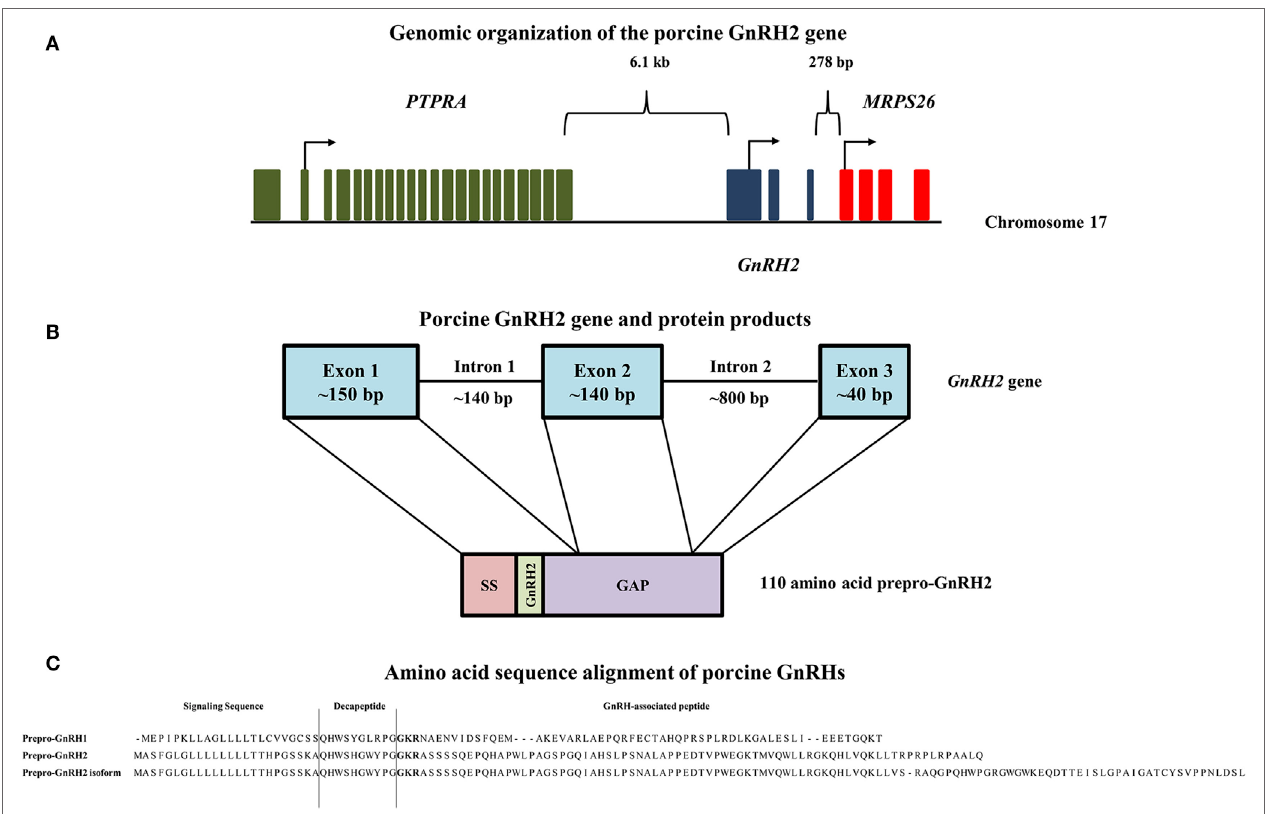
FiGURe 1 | Genomic organization of the porcine GnRH2 gene and its products. (A) The PTPRA gene (green) is located 6.1 kb upstream, whereas the MRPS26 gene (red) is positioned 278 bp downstream of the porcine GnRH2 gene (blue) on chromosome 17. Arrows indicate start codons for each gene. (B) The porcine GnRH2 gene contains three coding exons and two introns. Exon 1 (~150 bp) of the porcine GnRH2 gene encodes the signaling sequence (SS), mature GnRH2 decapeptide, and a portion of the GnRH-associated peptide (GAP). Exon 2 (~140 bp) and exon 3 (~40 bp) encode the remaining GAP sequence. Note that introns and exons are not drawn to scale. (C) Amino acid sequence alignments of predicted porcine prepro-GnRH2 isoforms (NCBI accession numbers XP_005672842 and XP_013840618) with porcine prepro-GnRH1 (NCBI accession number NP_999439). Prepro-GnRH1 is 91 amino acids in length compared with prepro-GnRH2, which has 110 residues. An isoform of prepro-GnRH2 (143 amino acids) is also predicted to be produced from the porcine GnRH2 gene due to alternative splicing. The amino acids that correspond to the SS, the mature decapeptide, and the GAP are indicated. The proteolytic cleavage sites are highlighted in